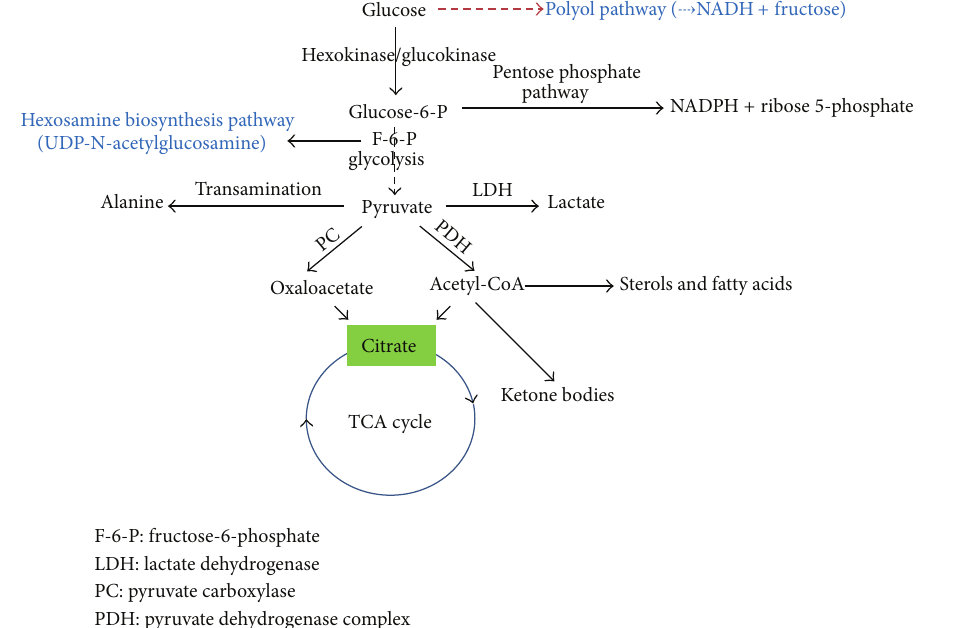
Figure 2: Fate of glucose. The major pathways shown in this diagram are glycolysis, the TCA cycle, and the pentose phosphate pathway. Additionally, glucose can be used as sources for fatty acid synthesis and lactate and alanine formation and can also be stored as glycogen in liver and skeletal muscle (not shown in the diagram). The pathways in blue (the polyol pathway and the hexosamine pathway) can be significant ones for glucose utilization under diabetic